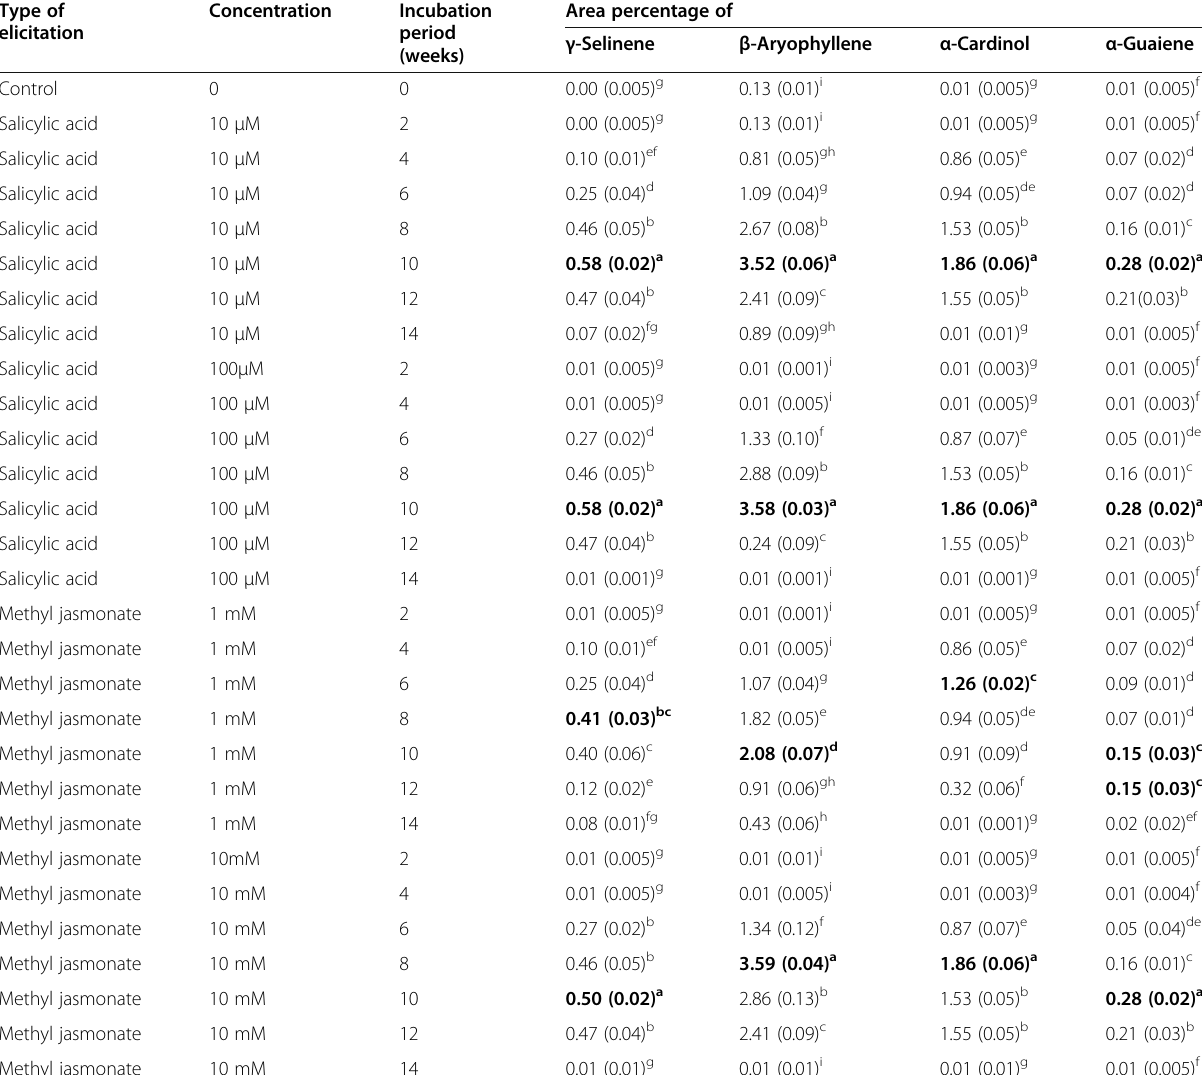
Table 1 Effect of Chemical elicitors on Gyrinops walla calli